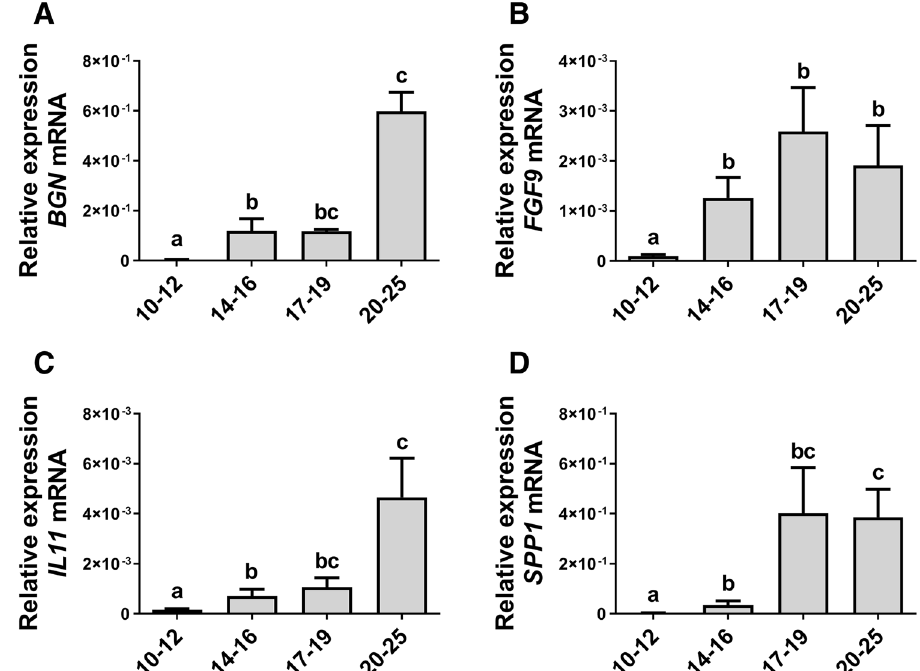
Figure 2. Expression of some of pregnancy-related genes is upregulated in the conceptus/trophoblast during embryo implantation and early placentation. The expression profiles of biglycan ( BGN ) ( A ); fibroblast growth factor 9 ( FGF9 ) ( B ); interleukin 11 ( IL11 ) ( C ), and secreted phosphoprotein 1 ( SPP1 ) ( D ) mRNA in the porcine conceptus/trophoblast on days 10–12 (preimplantation stage; spherical and tubular forms), 14–16 (beginning of attachment/implantation; filamentous forms), 17–19 (implantation stage, filamentous forms) and 20–25 (chorion which originates from trophoblast, the onset of placenta development) of pregnancy. Data are presented as means ± SEM. Different letters (a–c) indicate statistically significant differences ( P < 0.05). Means sharing at least one the same letter indicate no significant